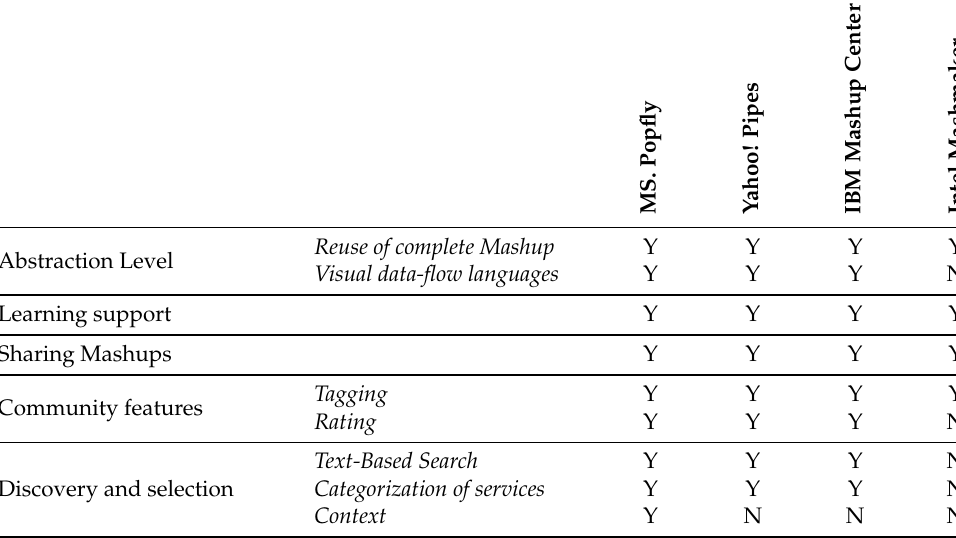
Table 1. Summary of the most relevant features offered by some Mashups